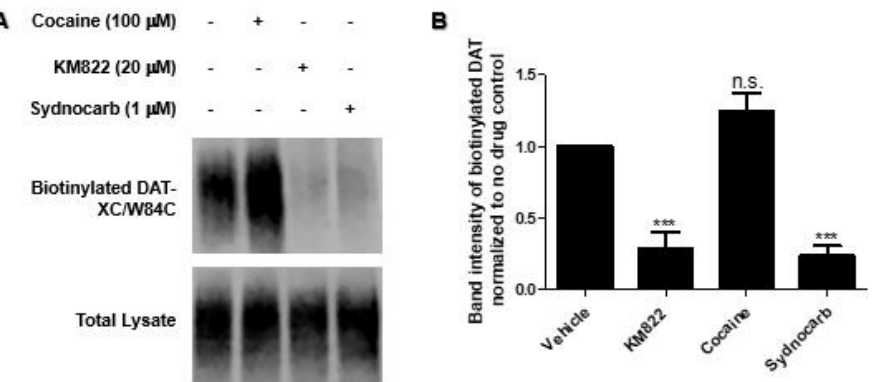
Figure 5. Analysis of the substituted cysteine scanning mutagenesis results. ( A ). Representative immunoblots of biotinylated DAT-XC/W84C mutant and total DAT protein in the presence of the vehicle, cocaine (100 µ M), KM822 (20 µ M), and sydnocarb (1 µ M). ( B ). Quantification of the biotinylation data. The biotinylated DAT is normalized to the total DAT protein and then, the drug-treated biotinylated DAT band intensity is normalized to the untreated band intensity. The data represents four independent experiments. Statistical analysis was performed using one-way ANOVA with Dunnett’s multiple comparison to determine the significance between drug-treated and untreated samples. ***, p < 0.001; n.s., no significance.